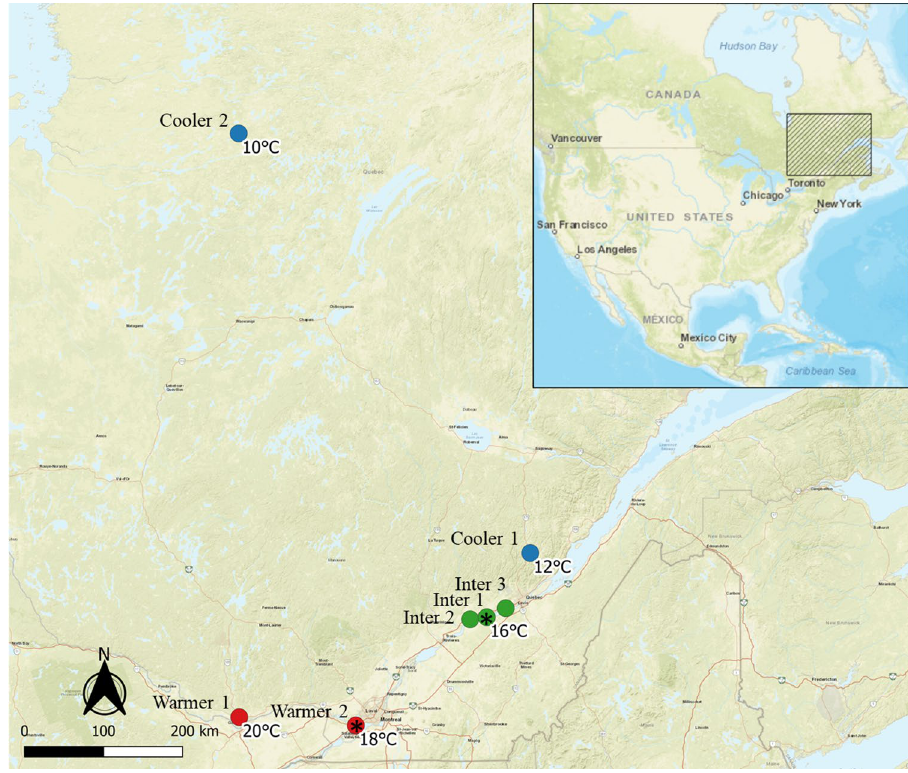
Figure 7. Location of the bat box installation sites at cooler (blue), intermediate (green) and warmer (red) sites in Quebec, Canada, from 2016 to 2019 with mean temperature in June. The Montmorency forest is considered a colder site due to its high elevation of 750 m. Structure and orientation tests occurred at sites represented by a star. Map derived from ESRI Standard https:// server. arcgi sonli ne. com, modified with QGIS 3.4.4. software (www. qgis.